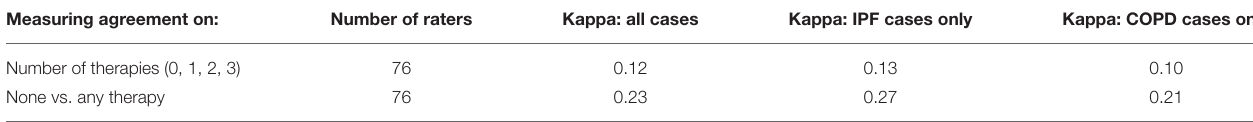
TABLE 2 | Fleiss’ Kappa calculations for all respondents who completed the entire survey ( n = 76).